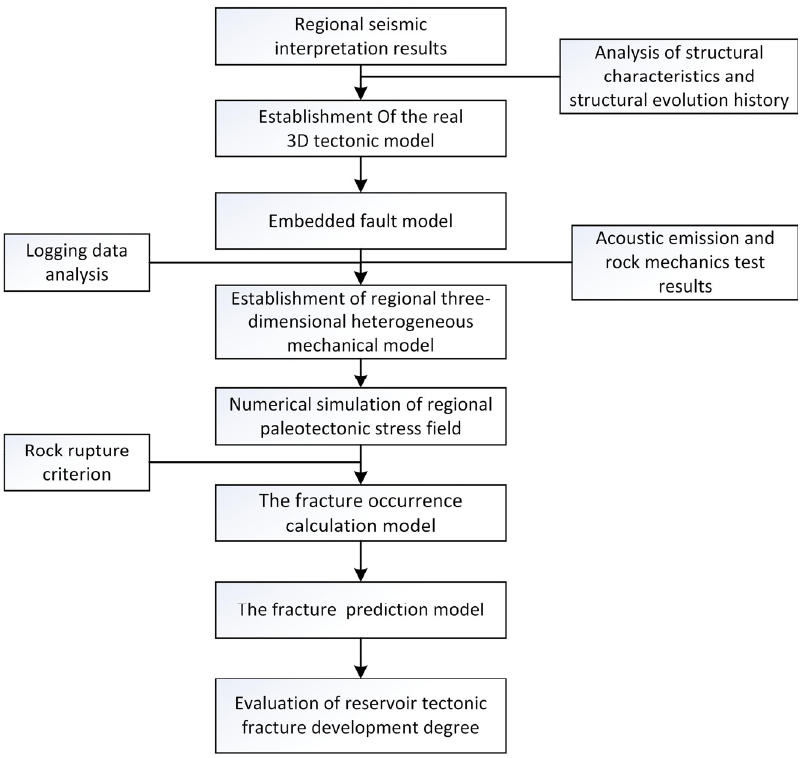
Figure 3. Flow chart for evaluation of the reservoir tectonic fracture development.